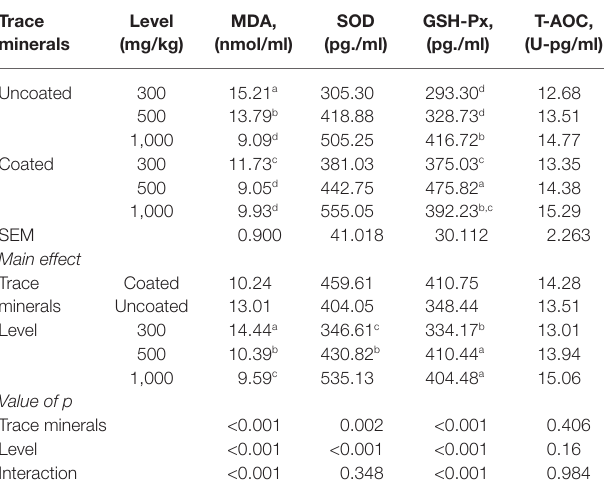
TABLE 9 | Effects of trace mineral type (coated or uncoated) and supplementation level (300, 500, or 1,000 mg/kg) of trace minerals on duck cecal microbiota ⍺